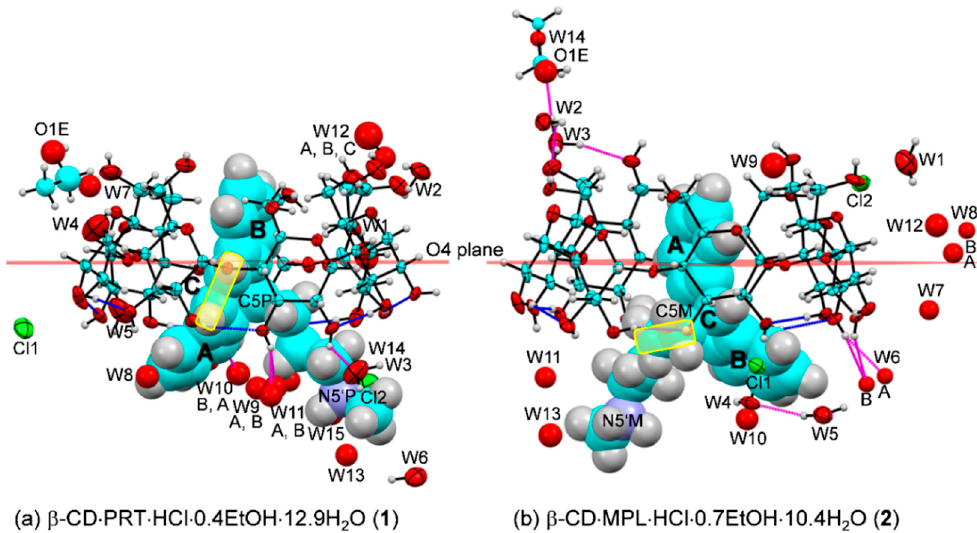
Figure 4. β -CD inclusion complexes with ( a ) PRT 1 and ( b ) MPL 2 in the solid state at 296 K (ORTEP plots at 20% probability level). For clarity, the drug molecules are shown in the space-filling model. The O–H···O hydrogen bonds stabilizing the round β -CD and the asymmetric unit are indicated by blue and magenta connecting lines, respectively. The -CH=CH- bridge of PRT and the -CH 2 –CH 2 - flexure of MPL at the central C-ring are emphasized in yellow areas. Note the reverse inclusion modes of PRT B-ring and MPL A-ring in the β -CD cavity.